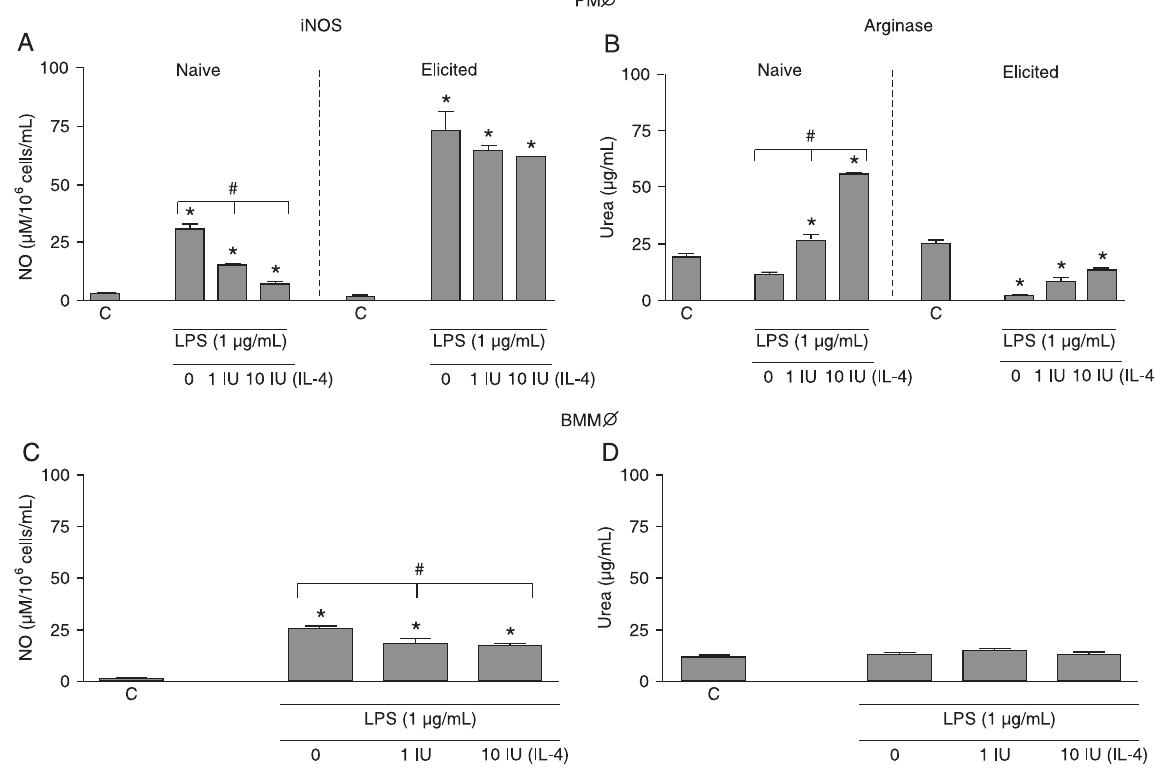
Figure 2. Effects of IL-4 on LPS-induced inducible nitric oxide synthase (iNOS) and arginase activities in macrophages of young BALB/c mice (N = 6 per group). Naive and elicited peritoneal macrophages (PMΦ) and bone marrow-derived macrophages (BMMΦ) from young BALB/c mice were incubated with lipopolysaccharide (LPS; 1 µg/mL) in the presence or absence of interleukin-4 (IL-4; 1 or 10 IU/mL) for 48 h, at 37°C, in 5% CO 2 . Cells of the control groups (C) were incubated in the absence of stimuli. Nitrite was mea- sured in the culture supernatants using Griess reagent, and arginase activity was determined in cell lysates based on the amounts of urea produced from L-arginine. All studies were conducted in triplicate. Bars indicate the means ± SEM of nitrite (Panels A, B) and urea (Panels C, D) levels in three independent experiments. *P ≤ 0.05 (comparison was carried out by the Student t -test) and # P ≤ 0.05 (comparison was carried out by ANOVA followed by the Bonferroni